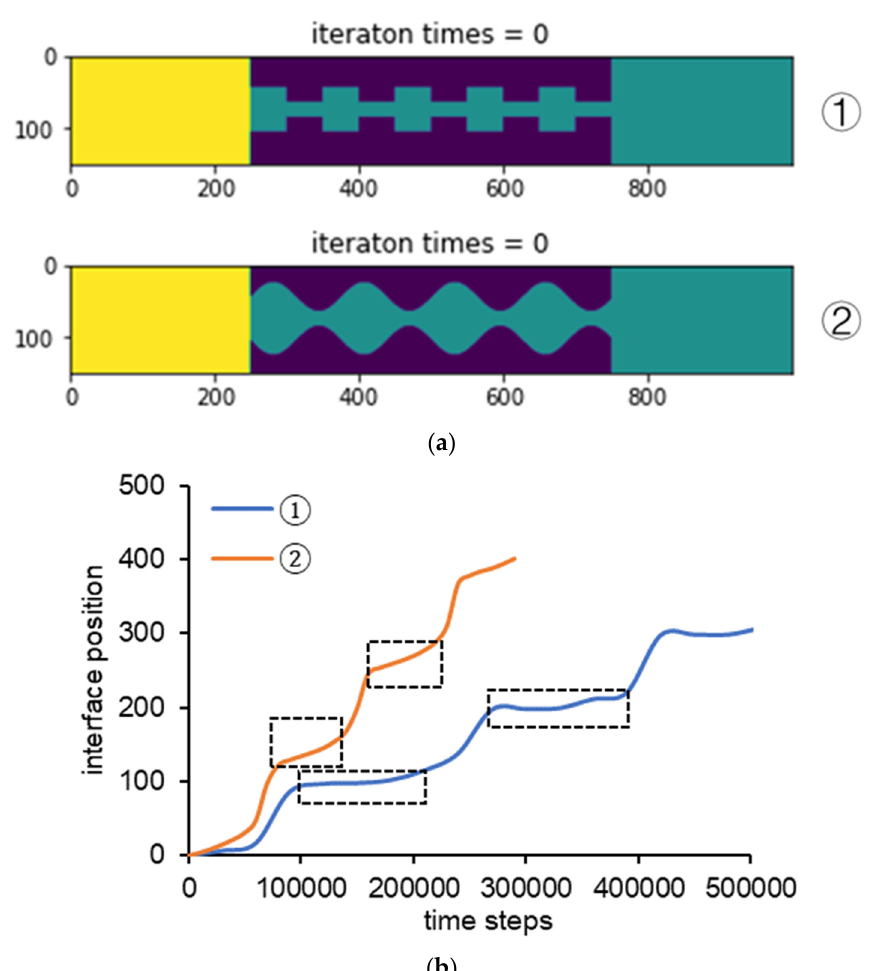
Figure 20. Two capillary structures and their spontaneous imbibition curves. ( a ) Schematic of two capillary structures for the same pore-throat aspect ratio. ( b ) Simulated spontaneous imbibition interface position vs. time.